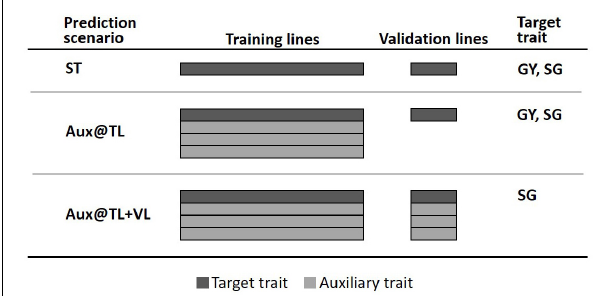
FIGURE 1 | Fivefold cross-validation schemes representing three prediction scenarios: ST, where only data of the target trait in the training lines set (TLS) are used for prediction in the validation lines set (VLS); Aux@TL, where data of auxiliary traits in TLS are included for prediction of the target trait in VLS; and Aux@TL + VL, where data of auxiliary traits in both TLS and VLS are included for prediction of the target trait in VLS.